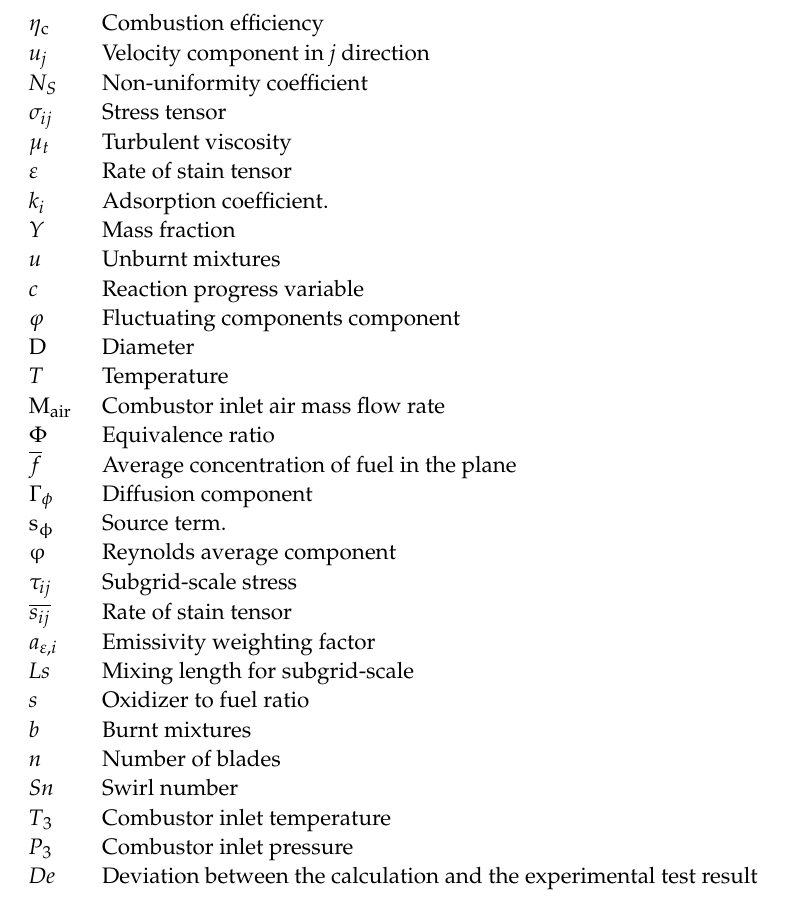
Deviation between the calculation and the experimental test